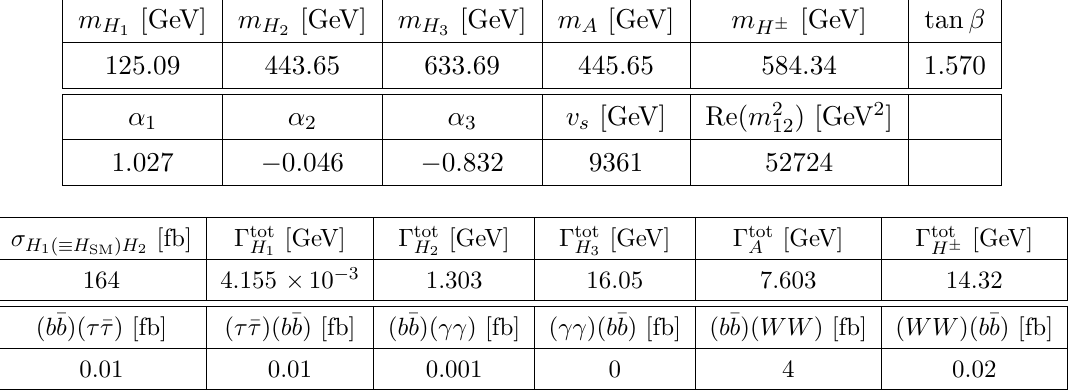
is given in tables 29 (upper) and (lower). The maximum rates at NLO QCD into ( b ¯ b )( t ¯ t ) for all investigated models in the various final state Higgs pair combinations are listed in table 30 for the cases that exceed 10 fb at